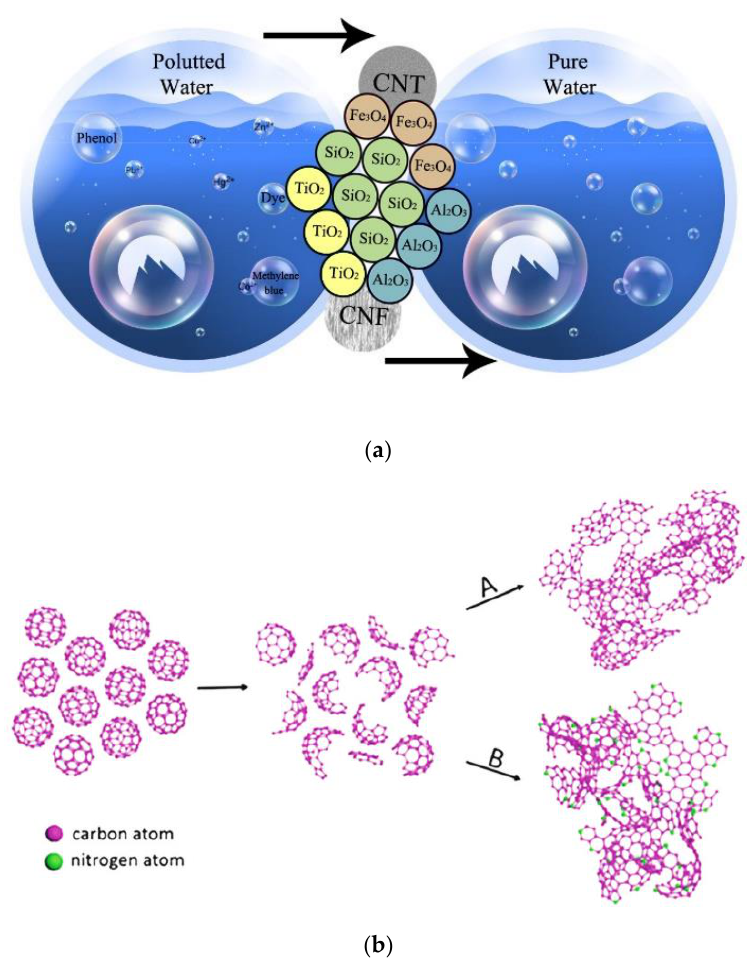
Figure 2. ( a ). Environmental uses of CNFs and CNTs, and ( b ) a diagram showing how KOH activates the C60 molecules. Route A depicts the typical activation carried out in an Ar flow, while Route B displays N- doping when NH3 flow is involved in the activation. Reprinted with permission from Ref. [31]. Copyright © 2016, John Wiley and